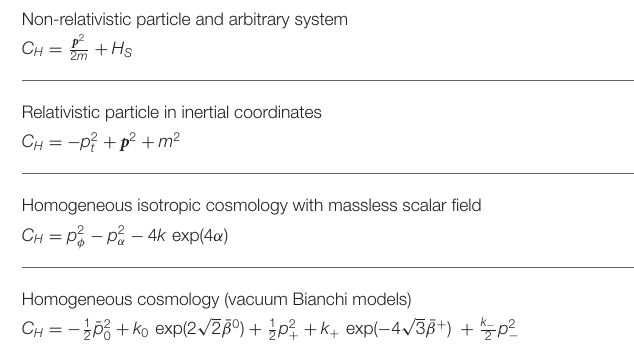
TABLE 1 | Examples of constraints of the form in Equation (10). Non-relativistic particle and arbitrary system